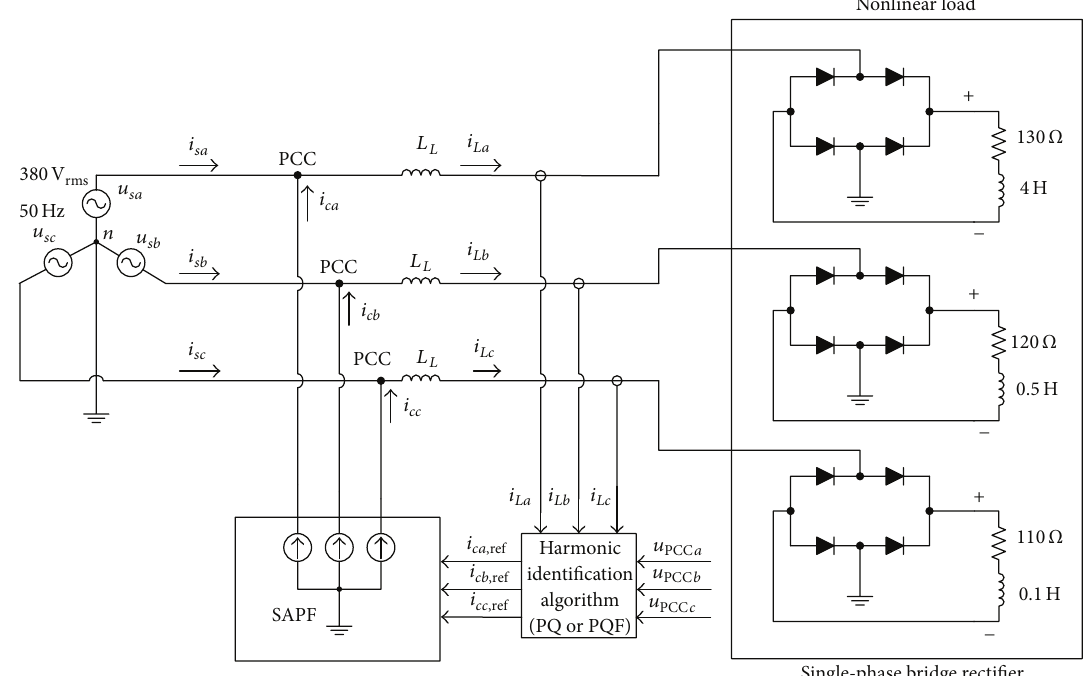
Figure 7: The unbalanced power system with ideal shunt active power